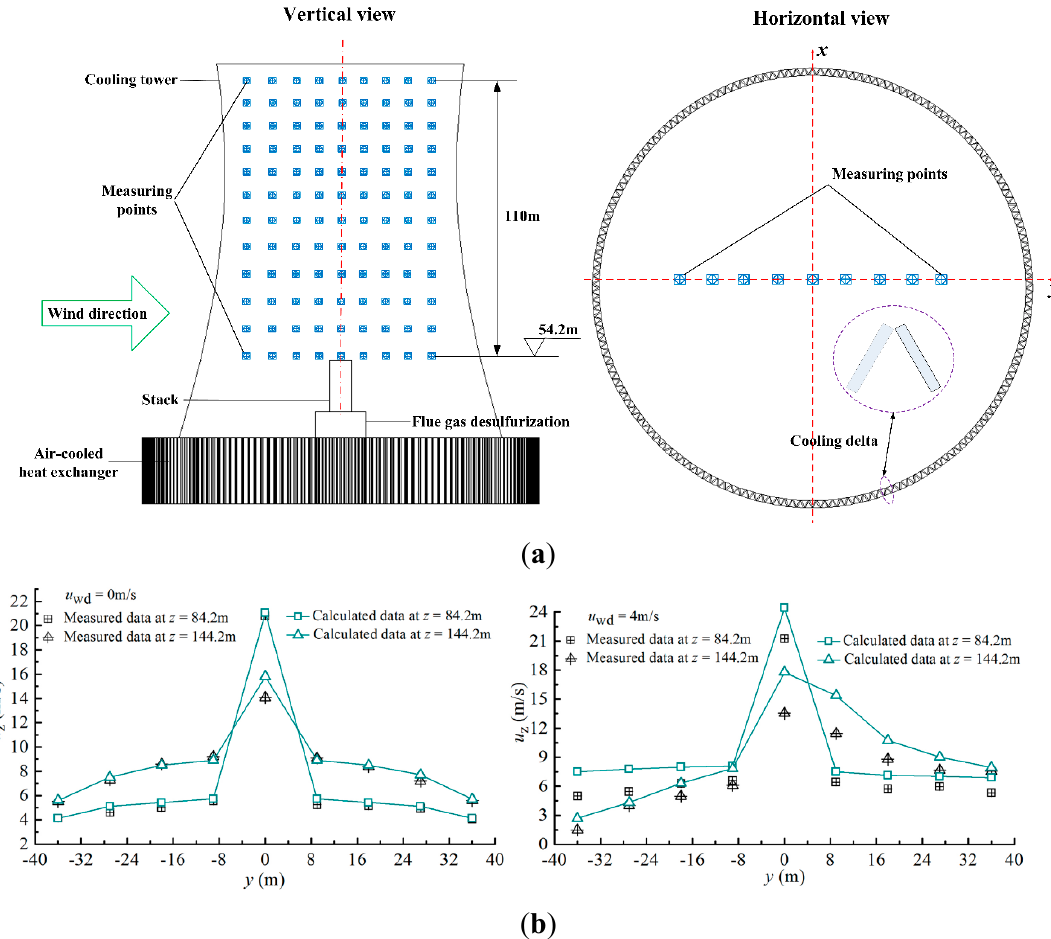
Figure 6. Experimental setup and results comparisons. ( a ) Measuring points, ( b ) comparisons of ascending velocities for two types of height-measuring points, without wind, and at a wind speed of 4 m/s.